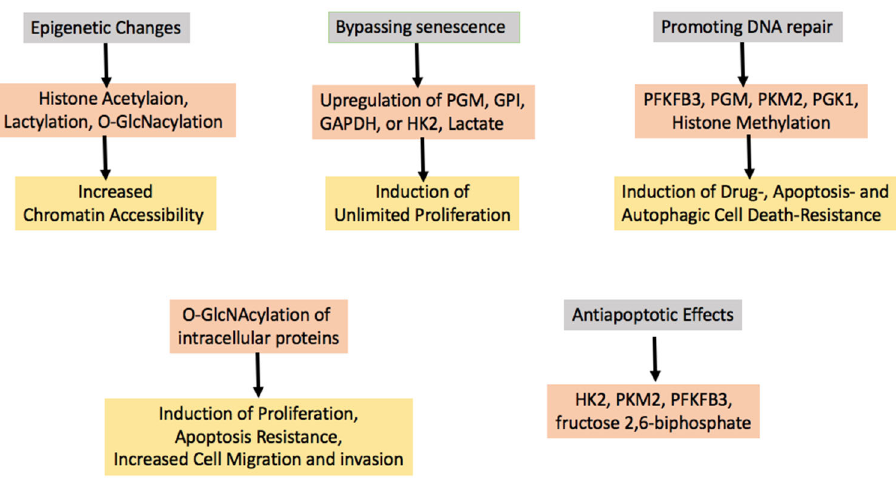
Figure 2. Mechanisms, Mediators, and Final Effects of Glycolysis-Induced Tumorigenesis. The figure depicts the mechanisms involved in glycolysis-induced tumorigenesis (grey-shaded boxes), the gly- colytic enzymes or metabolites that act as mediators (pink-shaded boxes), and the final effects that are induced in cells undergoing the tumorigenic process (yellow-shaded boxes). Abbreviations: GAPDH, glyceraldehyde 3-phosphate dehydrogenase; GPI, glucose 6-phosphate isomerase; HK, hexoki- nase; O-GlcNac, O -linked β - N -acetylglucosamine; PFKFB3, 6-phosphofructo-2-kinase/fructose-2,6- biphosphatase 3; PGM, phosphoglycerate mutase; PGK, phosphoglycerate kinase; PKM2, pyruvate kinase